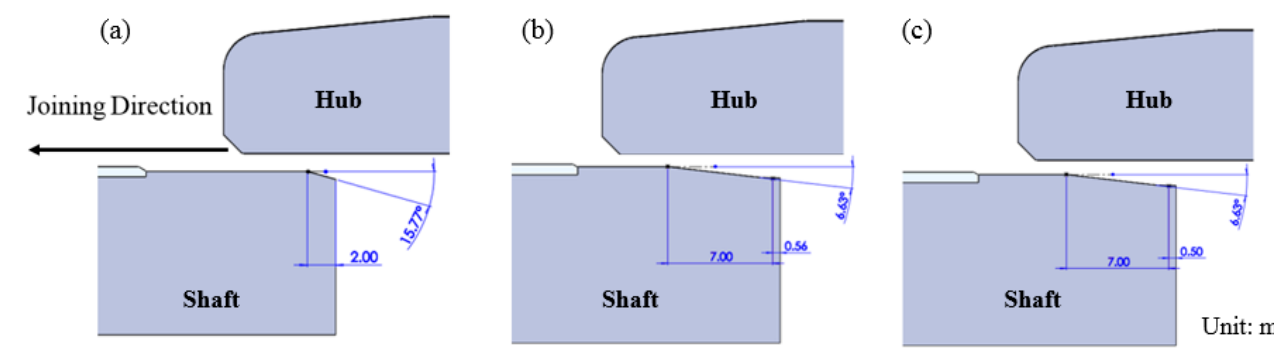
Figure 5. Different version of shaft dimensions: ( a ) version 1, ( b ) version 2, and ( c ) version 3.